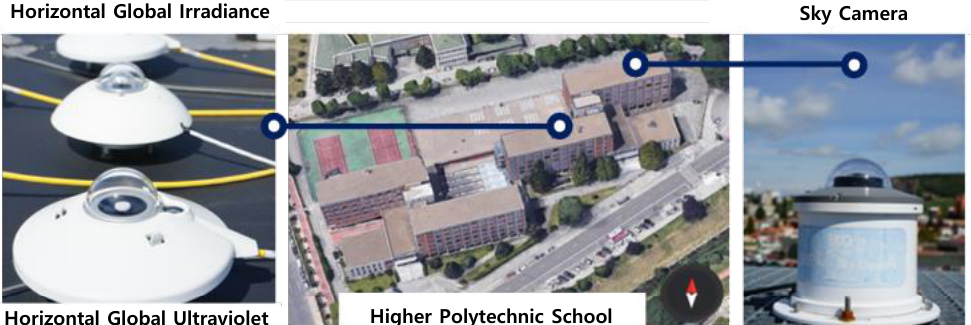
Figure 1. Experimental equipment. I I , and I GH , DH BH were measured with Hulseflux pyranometers (model SR11: